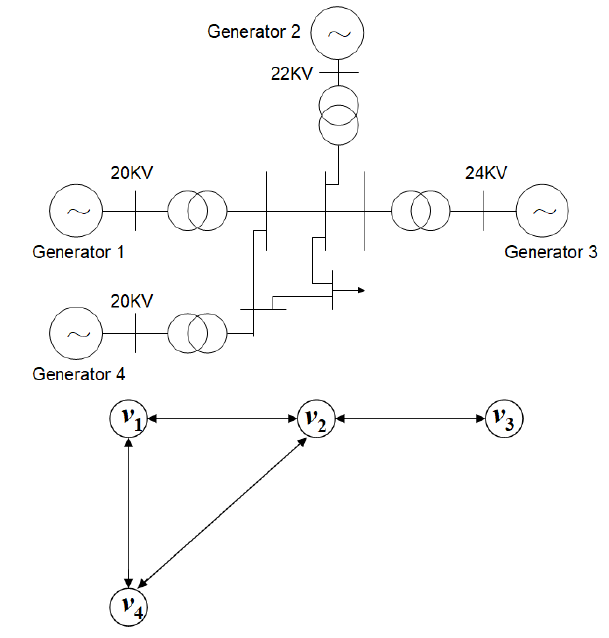
Figure 8. Above: structure of a power system; Below: the topology of a communication network.